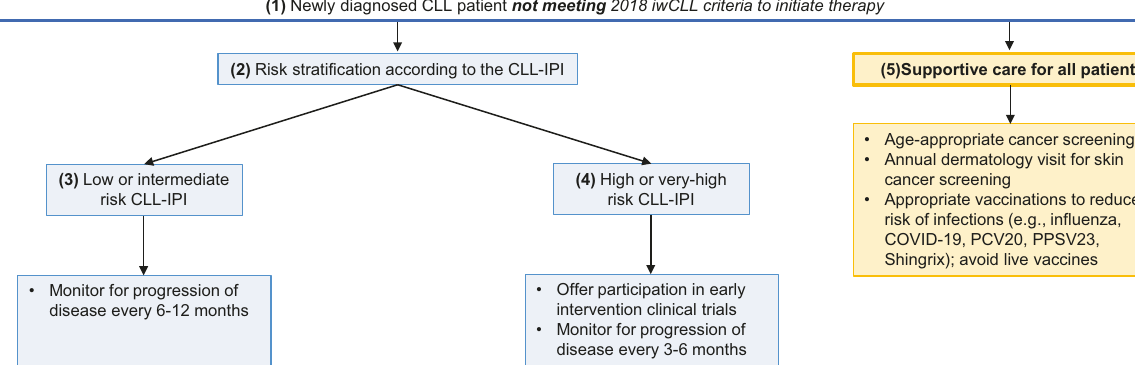
Fig. 1 Approach to the management of patients with newly diagnosed CLL who do not meet the 2018 International Workshop for Chronic Lymphocytic Leukemia (iwCLL) criteria for therapy. Management is guided by risk-strati fi cation, while including supportive care is necessary for all patients with a CLL